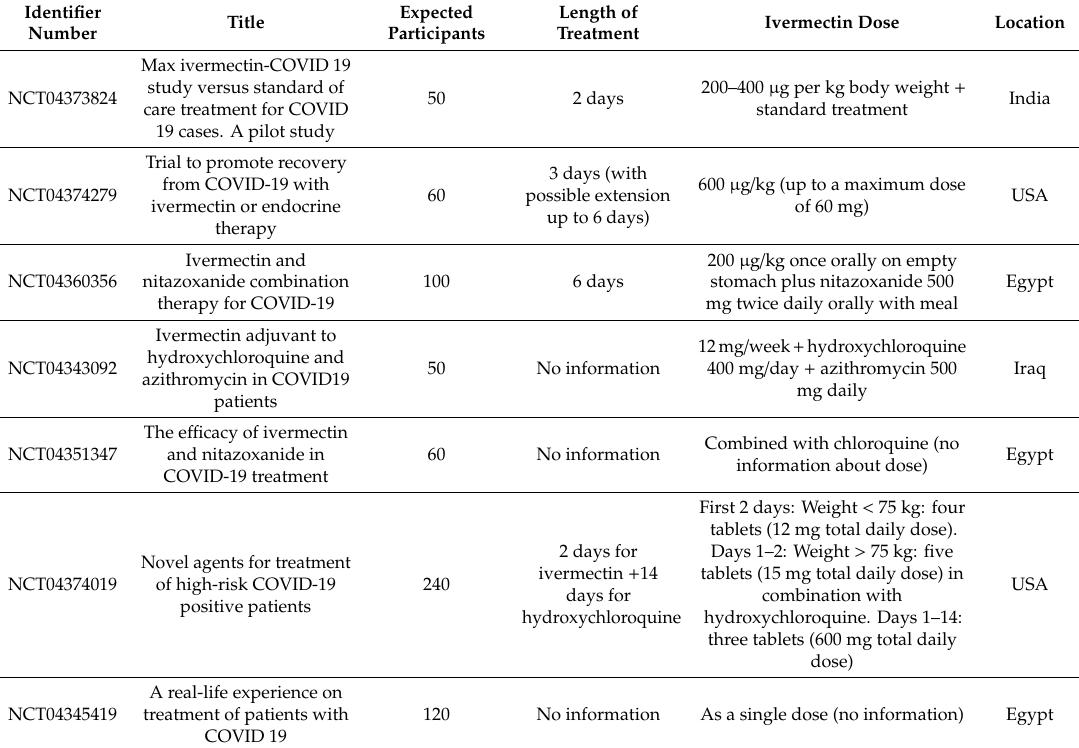
Table 1. A list of ongoing registered clinical trials of ivermectin to treat